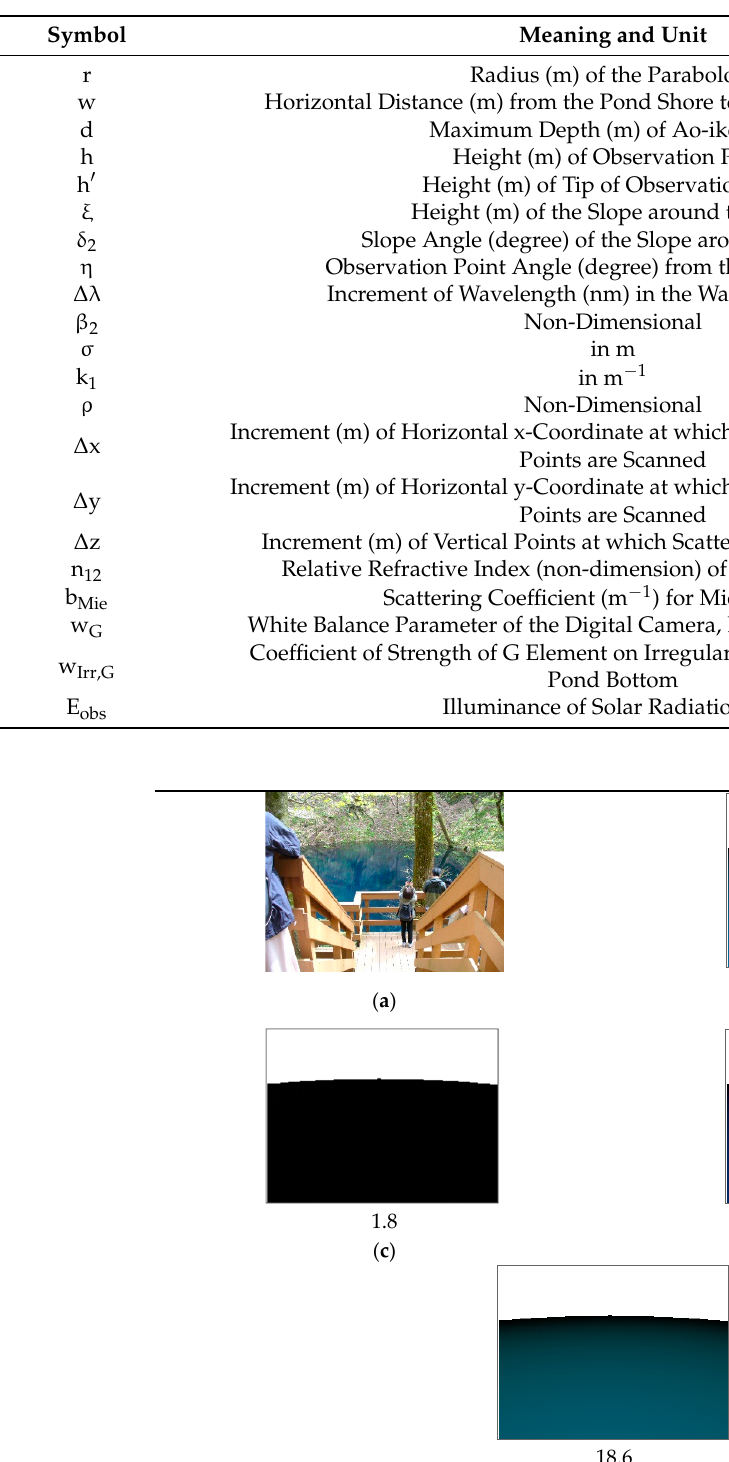
Table 2. Given and settled parameters in image analyses when the influence of shading over the pond surface by leaves was small.